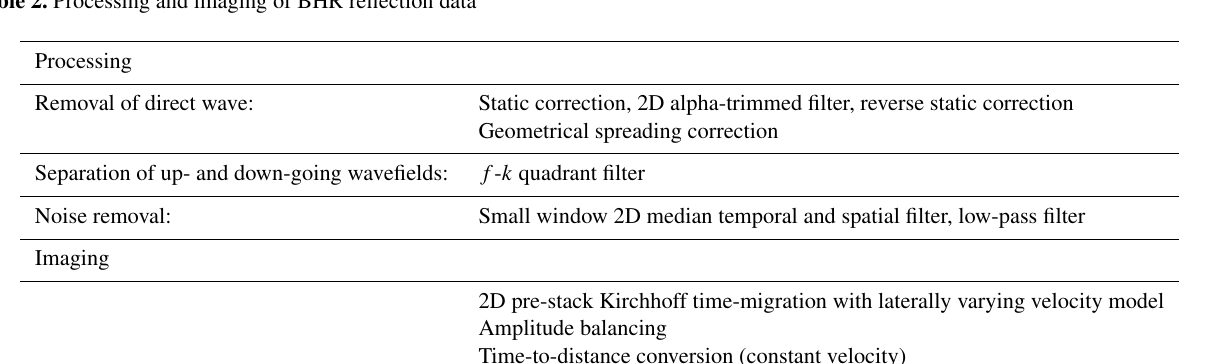
Table 2. Processing and imaging of BHR reflection data